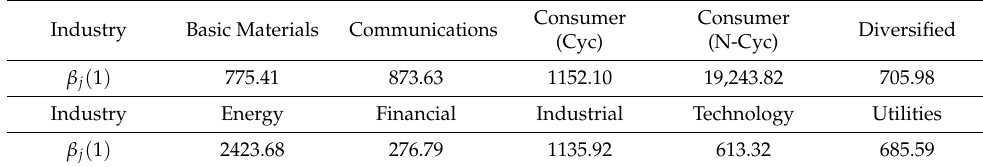
Table 1. Maximum pseudo-likelihood estimates for β j (1) .